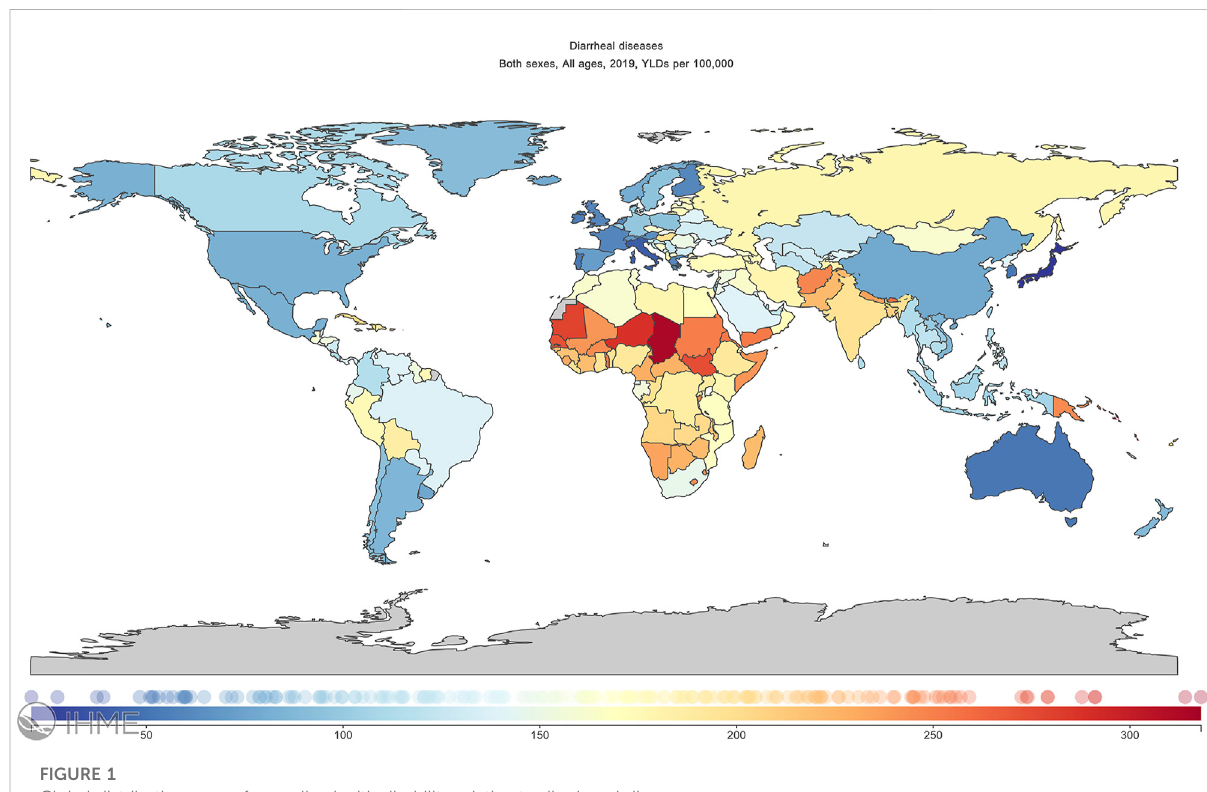
FIGURE 1 Global distribution map of years lived with disability relative to diarrhoeal